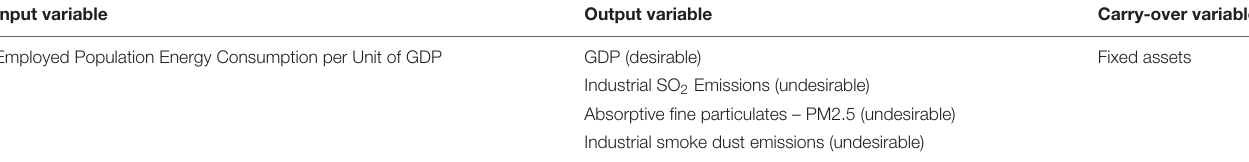
TABLE 1 | Input, output, and carry-over variables.